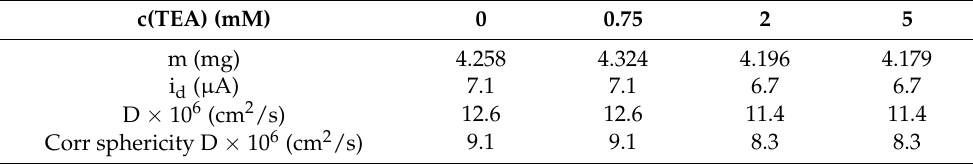
Table 1. Ilkovic equation (Equations (1) and (2)) with n = 2, c = 1.5 mM, t = 4